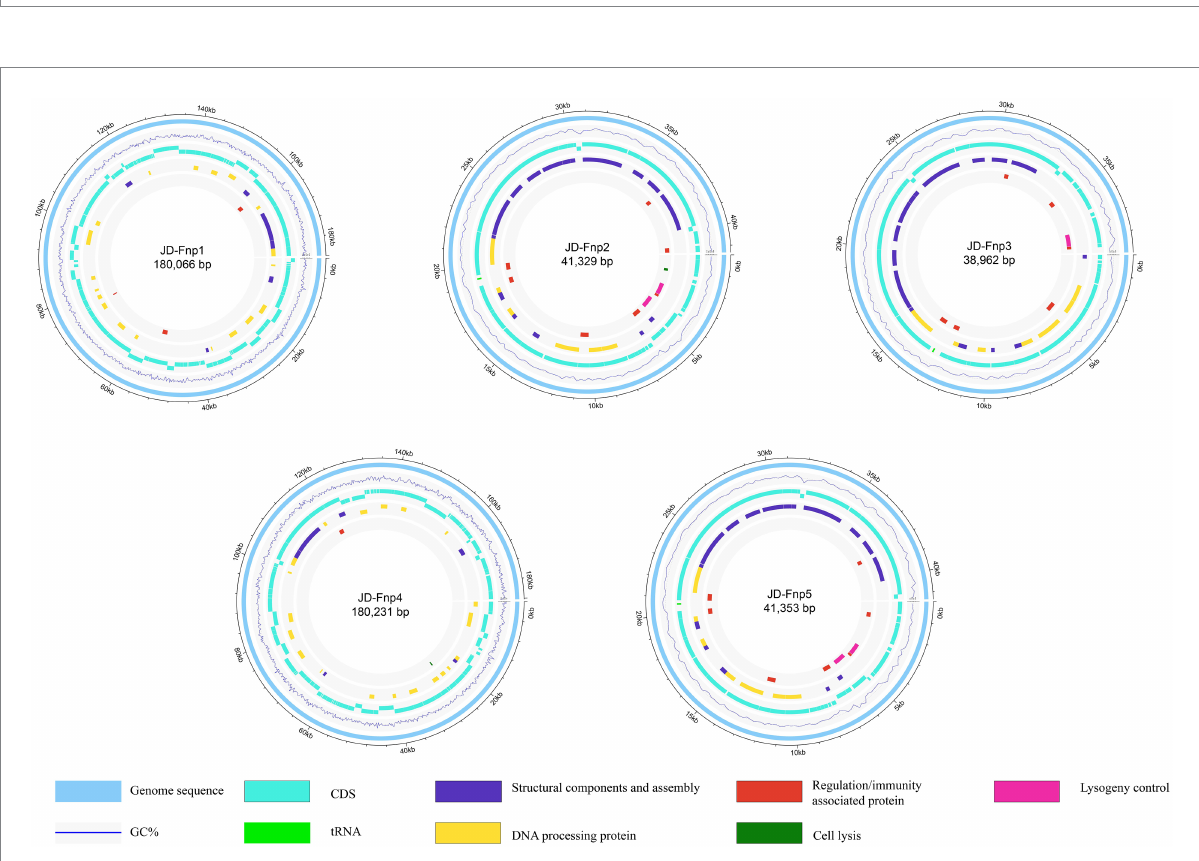
FIGURE 7 Complete genome sequences of JD-Fnp1 ~ JD-Fnp5. The functional modules were assigned based on gene annotation and genomic organization and are shown in different